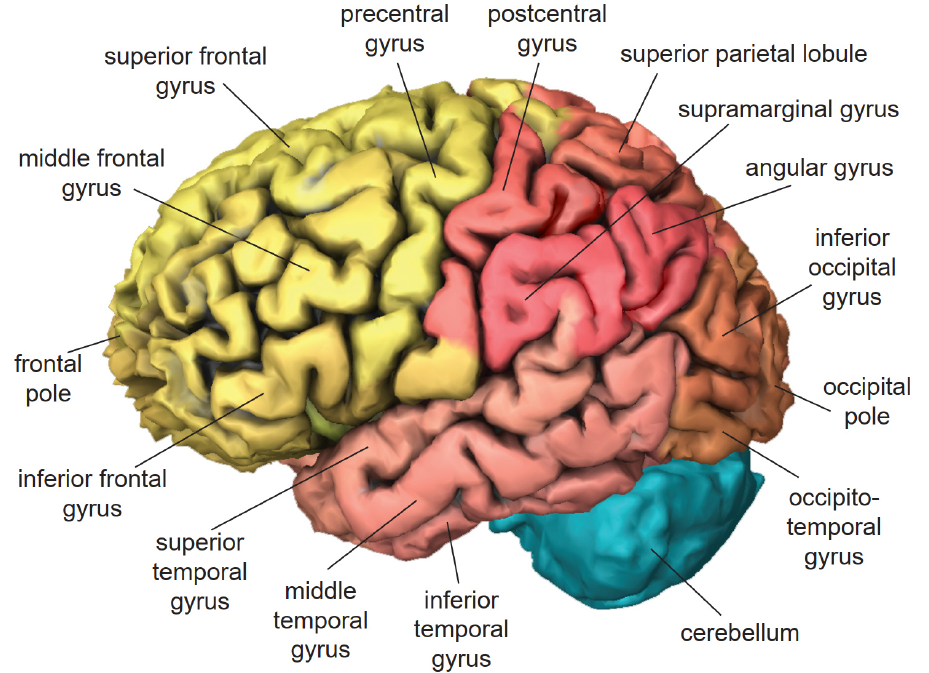
Figure 2. Lateral view of the left hemisphere of the human brain based on H0351.2002 dataset in Allen Brain Atlas. Frontal lobe (yellow), parietal lobe (red), temporal lobe (pink), occipital lobe (salmon), cerebellum